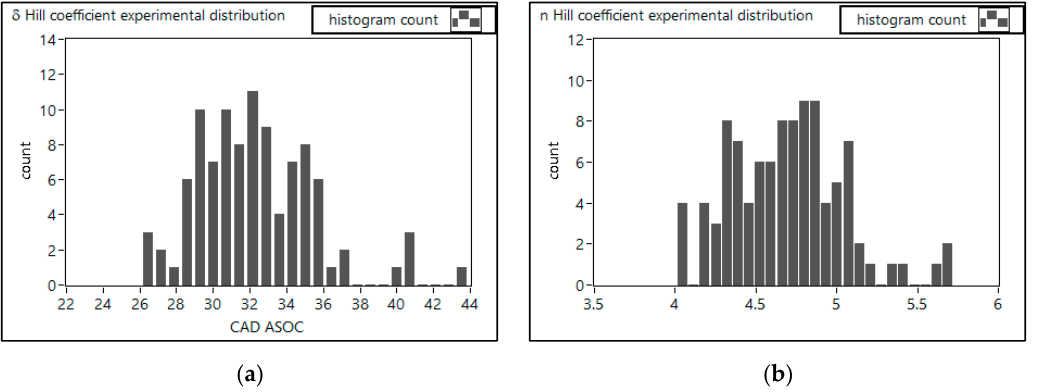
Figure 11. Histograms of Hill coefficients experimental distribution; MAP = 1 bar, n = 3500 rpm, fuel NG. ( a ) δ coefficient (mean value = 32.3 CAD, SD = 3.24 CAD; ( b ) n coefficient (mean value = 4.69, SD = 0.35).